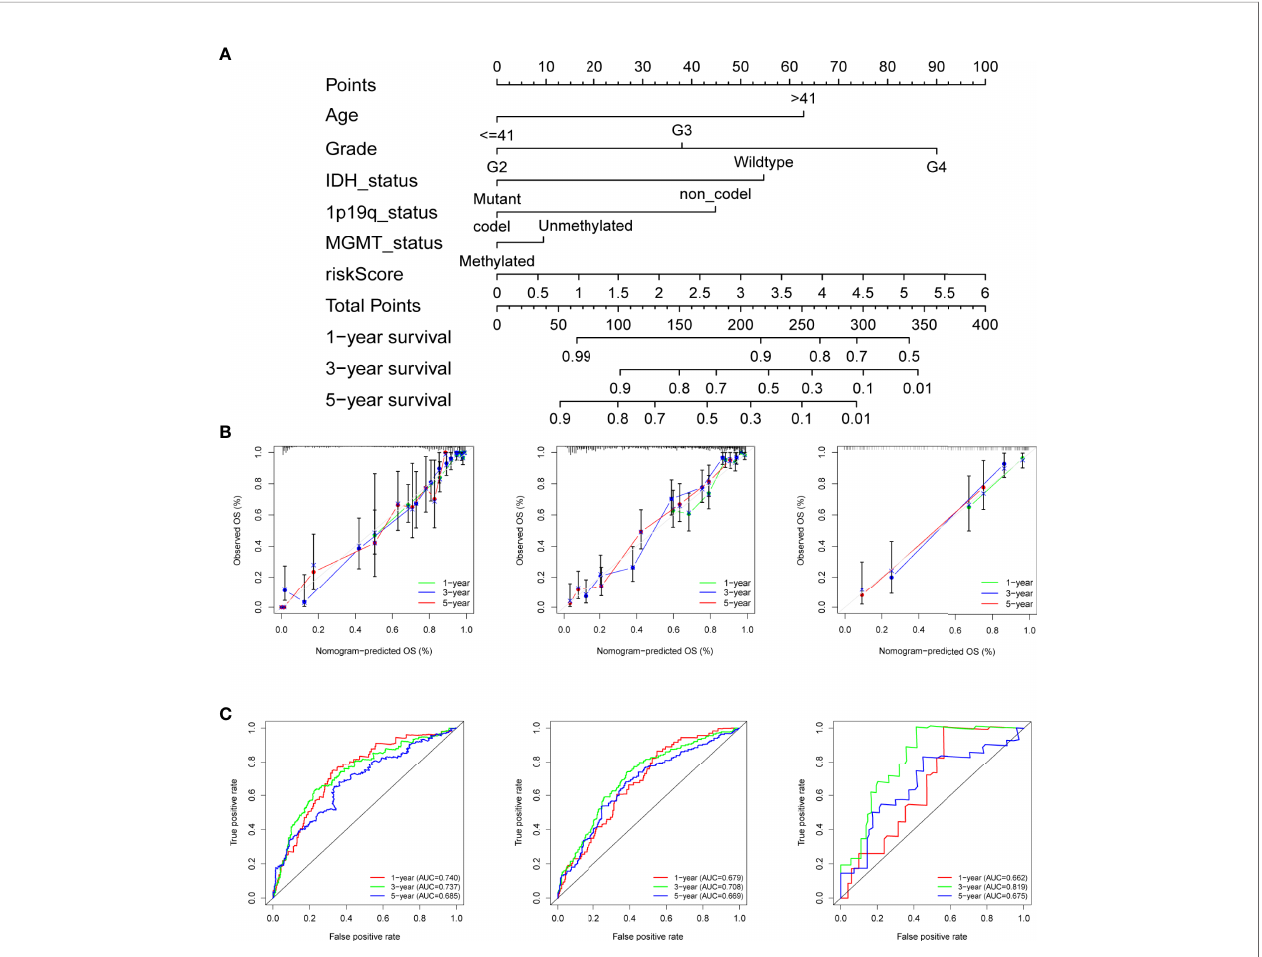
FIGURE 3 | Construction of the nomogram for predicting overall survival. (A) Nomogram plot for predicting the survival rates of glioma patients at 1, 3, and 5 years in the TCGA cohort. (B) The calibration curves of the nomogram for assessing the consistency of actual and predicting OS at 1-, 3-, and 5-year in the training and the two test cohorts. (C) ROC curves of nomogram at 1, 3, and 5 years in the different datasets